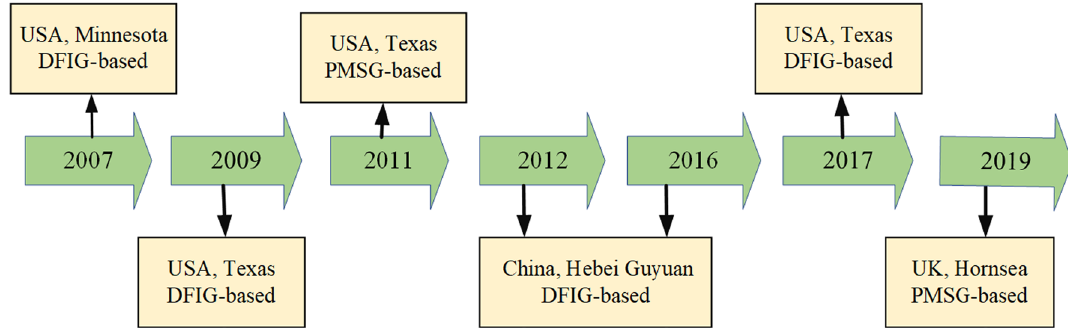
Fig. 4 Timeline of reported SSCCI events due to involvement of WPP and series compensated transmission line/weak